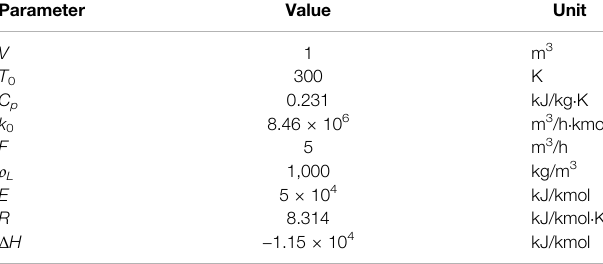
TABLE 2 | Parameters for the CSTR model.